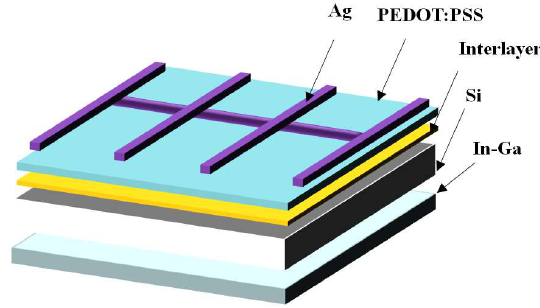
Figure 1. Schematic structure of planar hybrid n-Si/PEDOT:PSS solar cells.